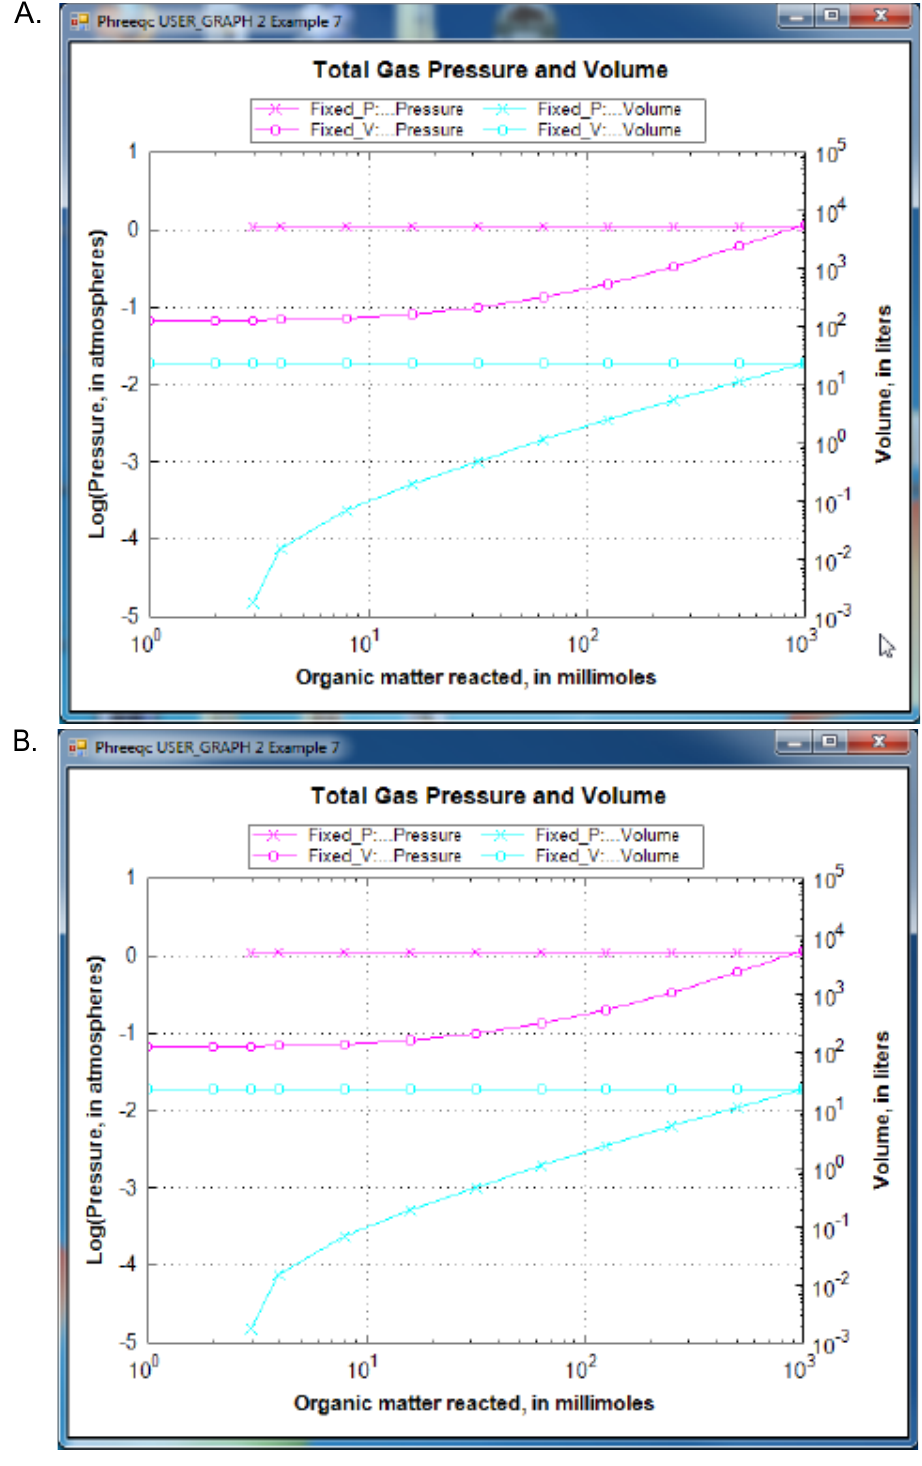
Figure 8. (A) Compositions and (B) total gas pressures and volumes of a fixed-pressure and a fixed-volume gas phase during decomposition of CH 2 O(NH 3 ) 0.07 (organic matter) in water. (The partial pressure of ammonia gas is less than 10 -7 atmospheres throughout and is not